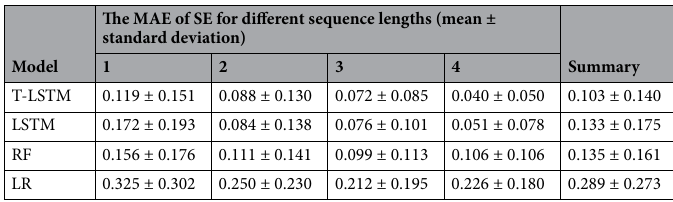
Table 5. Comparison of the MAEs of different models.